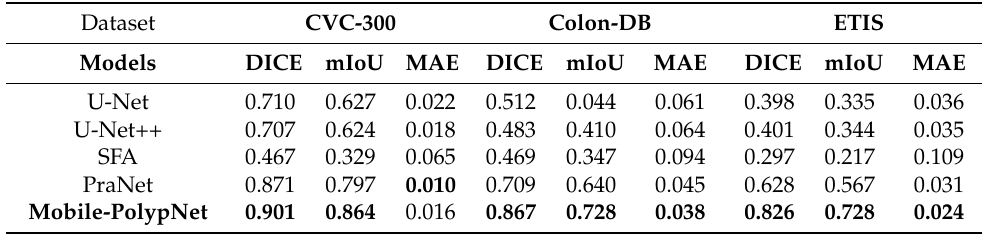
Table 2. Model’s accuracy comparison on the unseen test dataset CVC-300, Colon-DB, and ETIS. The bold is to identify the best of the column.